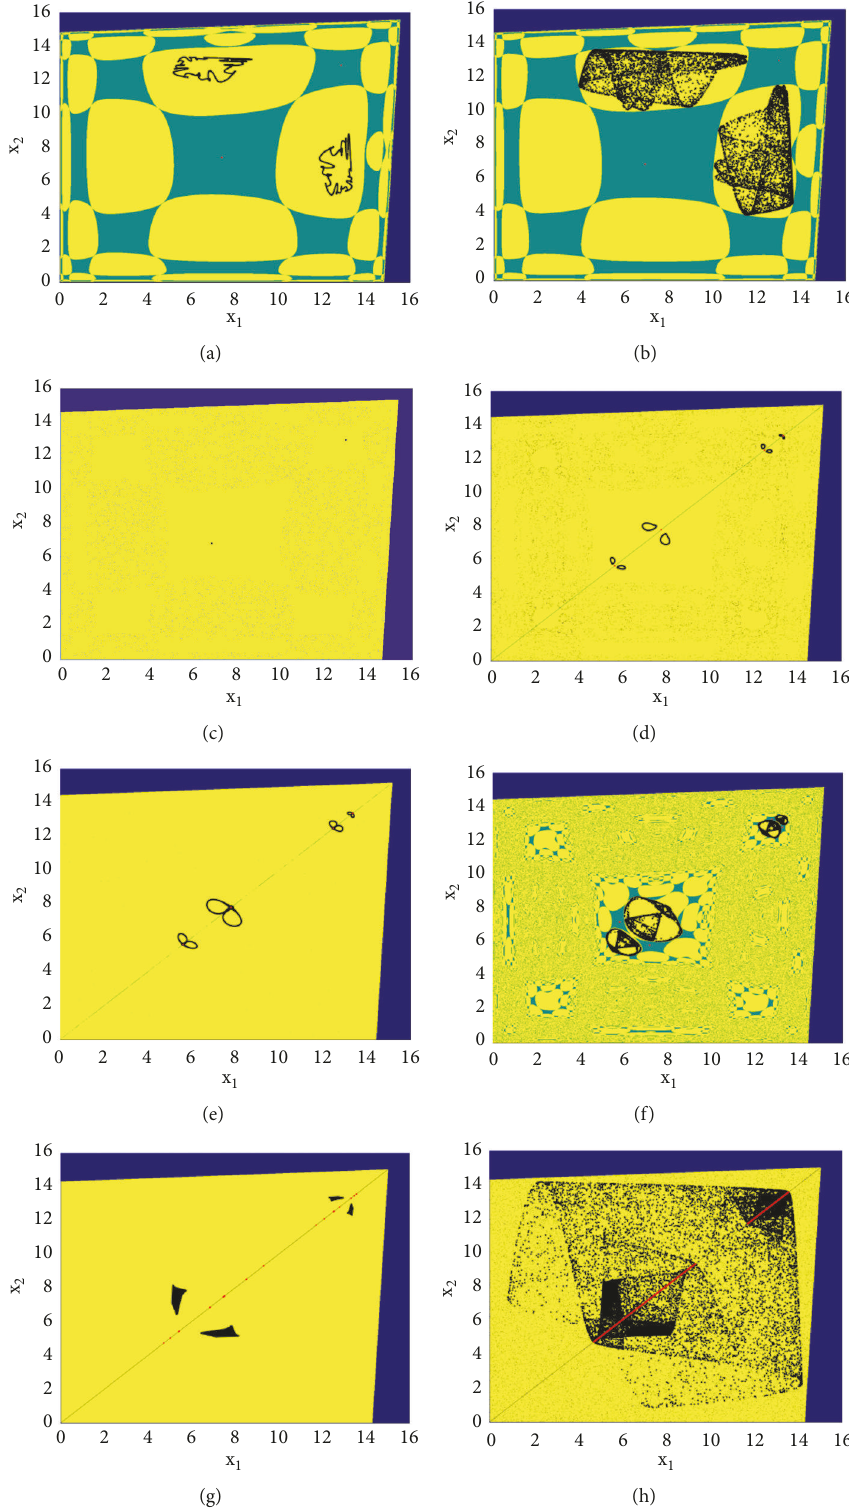
Figure 9: Basins of attraction and coexisting attractors of system (17) with 𝑎 = 7.12 , 𝑏 = 0.024 , 𝑐 = 0.98 , 𝛽 = 0.38 , 𝛾 = 0.44 , and 𝛼 = 𝛼 1 = 𝛼 ∈ [0.53325,0.60275] , where different colors represent attracting domains of different attractors. (a) 𝛼 = 0.53325 ; (b) 𝛼 = 0.55675 ; (c) 2 𝛼 = 0.557 ; (d) 𝛼 = 0.58117 ; (e) 𝛼 = 0.58225 ; (f) 𝛼 = 0.58525 ; (g) 𝛼 = 0.6025 ; (h) 𝛼 = 0.60275